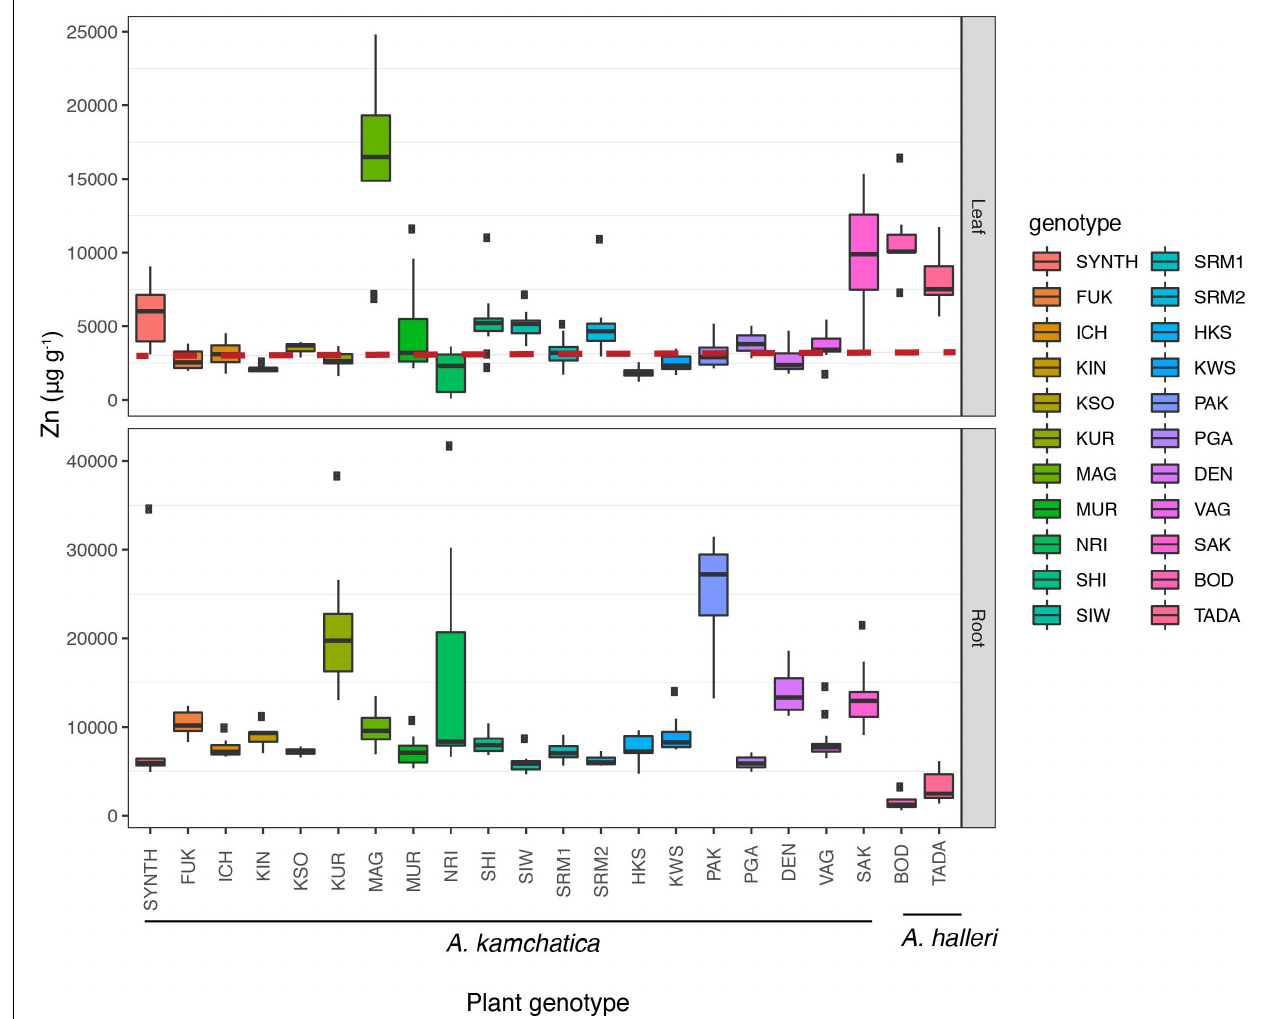
FIGURE 3 | Zinc accumulation in leaf tissues (Upper) and root tissues (Lower) in 20 A. kamchatica and two A. halleri genotypes after 1 week of 500 µ M zinc treatment in hydroponic chambers. The dashed red line represents 3,000 µ g. Boxplots: center line, median; box limits, upper and lower quartiles; whiskers, 1.5 × interquartile range; points, outliers. Boxplots are colored according to plant genotype. Refer to Supplementary Table 5 for mean and median values, standard deviations, and number of